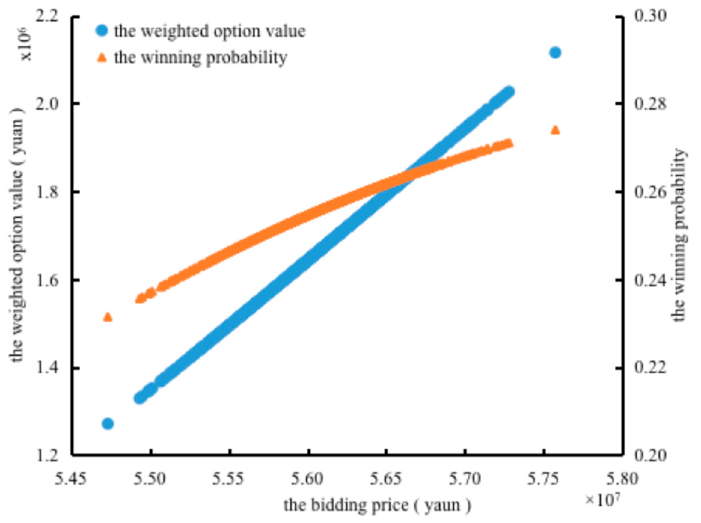
Figure 10. The concentration of the optimal bidding price.